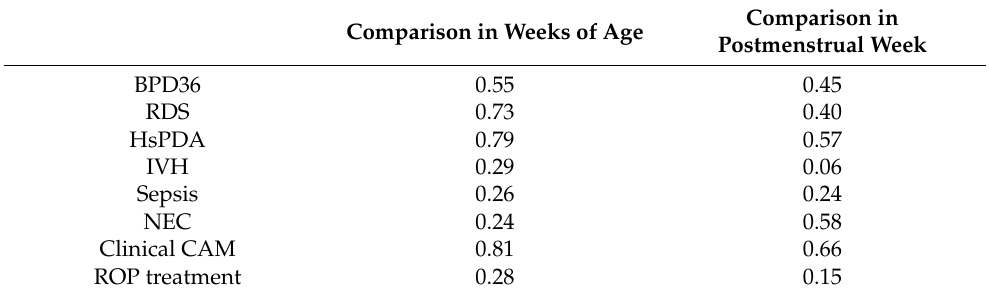
Table 3. Comparison of HRG Longitudinal Measurements with and without Complications. Comparison in Comparison in Weeks of Age Postmenstrual Week BPD36 0.55 0.45